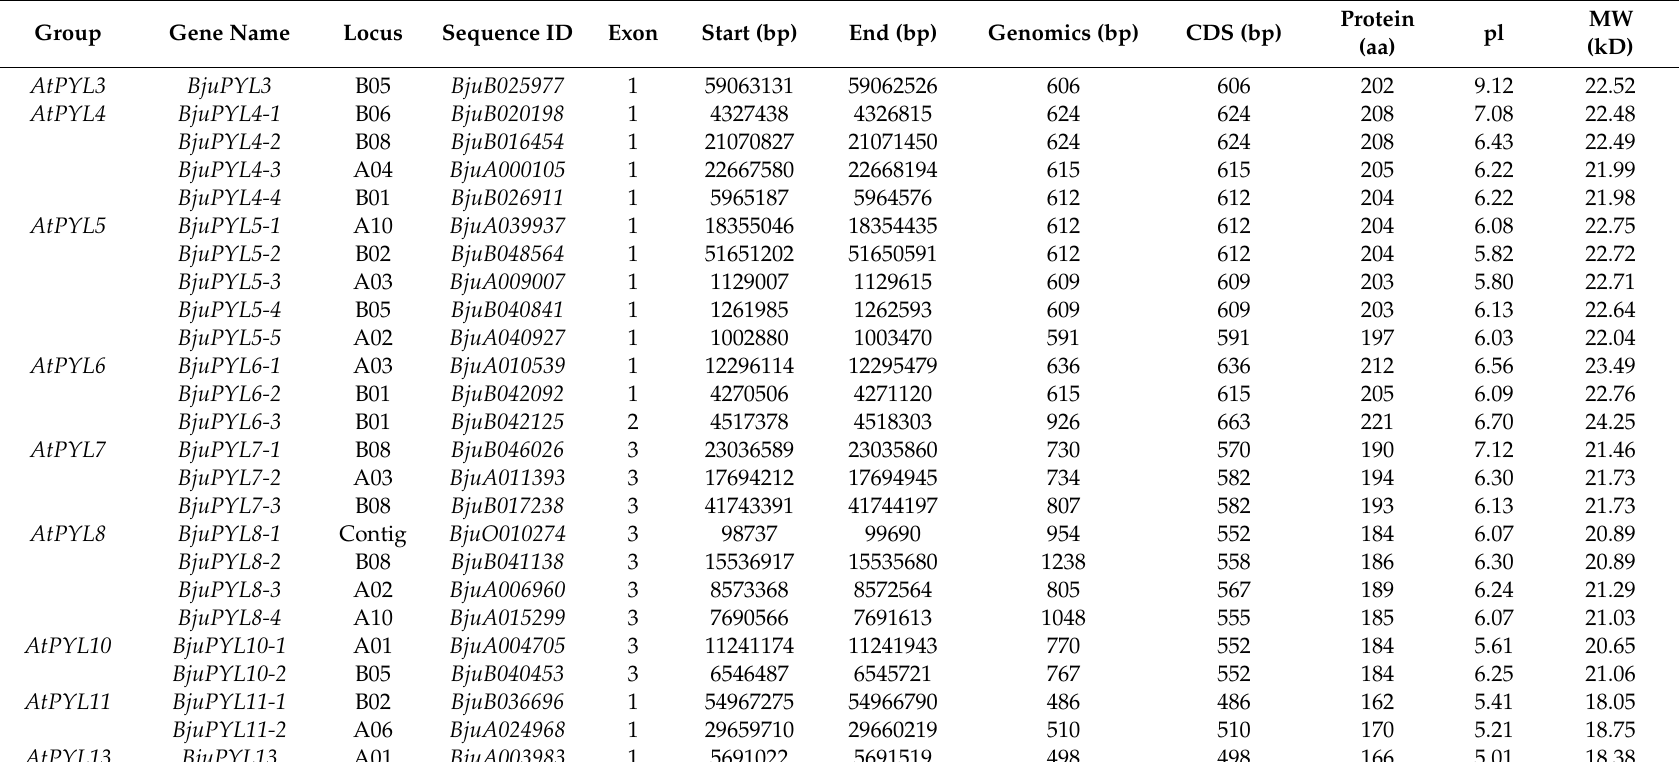
Table 1. The BjuPYLs family members in B. juncea var.